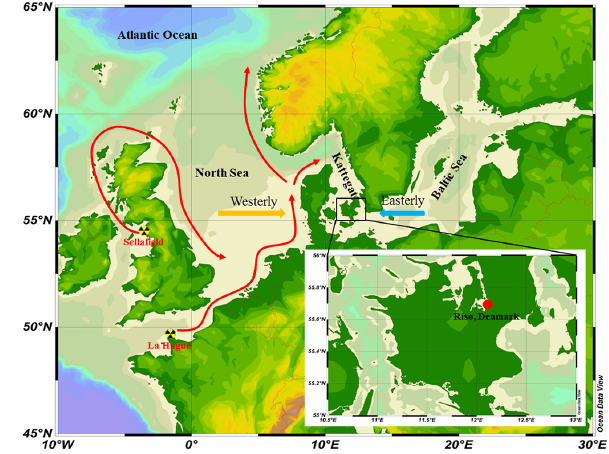
Figure 1. Map showing the sampling site (red dot in the inset) at Risø, Denmark for aerosol collection. The two nuclear reprocessing plants (radioactivity labels), Sellafield (United Kingdom) and La Hague (France) have released a large quantity of 129 I to the marine and atmospheric environment. This anthropogenic 129 I discharged to marine systems has been transported to the North Sea, Baltic Sea, Norwegian Sea, and beyond, by ocean currents (red lines). Yellow and blue arrows show the westerly wind and easterly wind, respec-